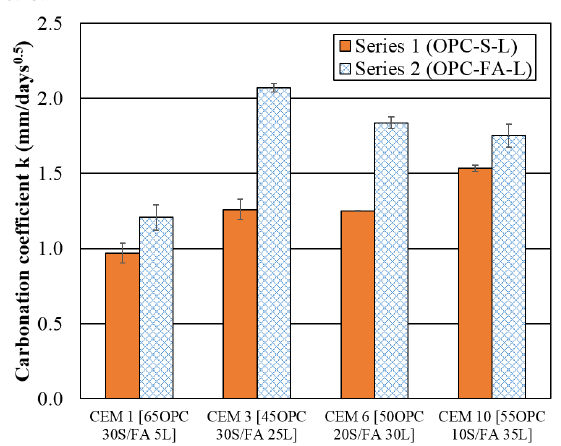
Figure 4. Carbonation coefficients for concretes with w/c of